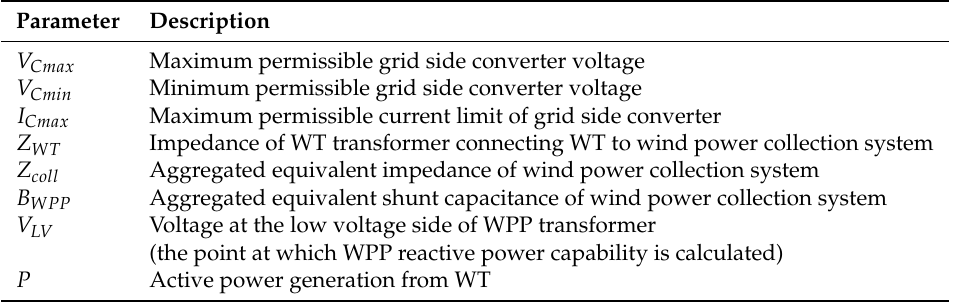
Table A1. Description of parameters required for proposed